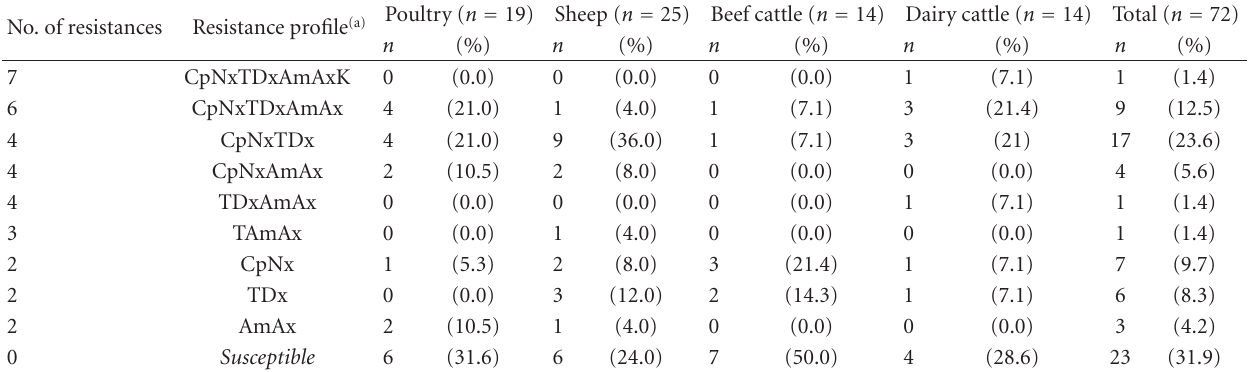
Table 3: Resistance phenotypes of C. jejuni isolates by source. No. of resistances